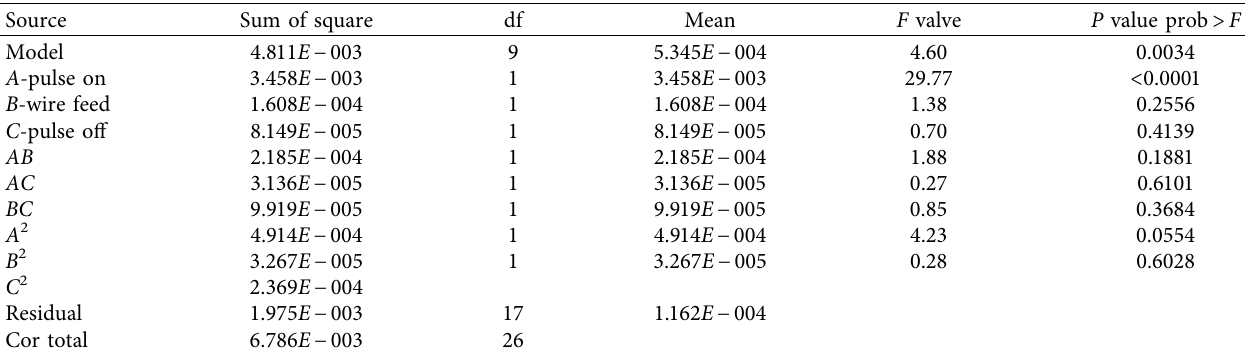
Figure 17shows the residual plots for means.